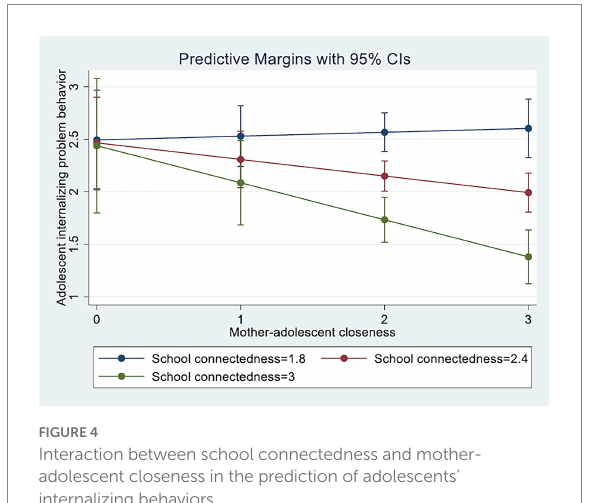
FIGURE 4 Interaction between school connectedness and mother- adolescent closeness in the prediction of adolescents’ internalizing